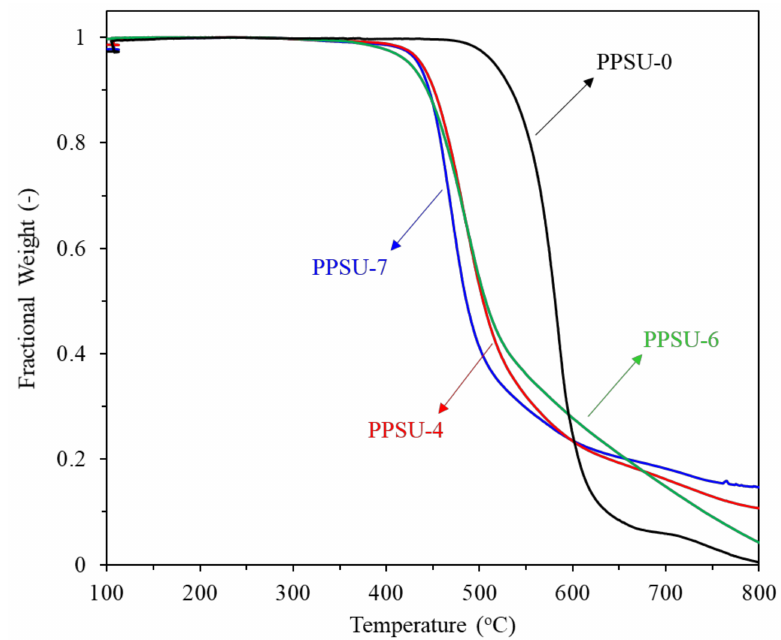
Figure 6. TGA spectra of